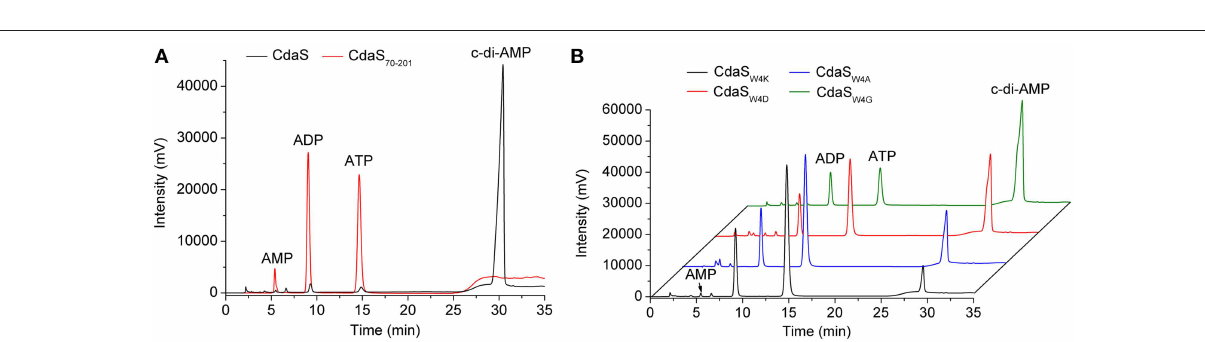
FIGURE 3 | The importance of the N-terminal region for the DAC activity of CdaS. (A) 1 µ M CdaS and CdaS 70 − 201 were incubated with standard reaction mixture at 37 ◦ C in a 100 µ L reaction volume for 8h. (B) 1 µ M of mutants CdaS W4G , CdaS W4D , CdaS W4A , and CdaS W4K were reacted as indicated in (A) and analyzed by